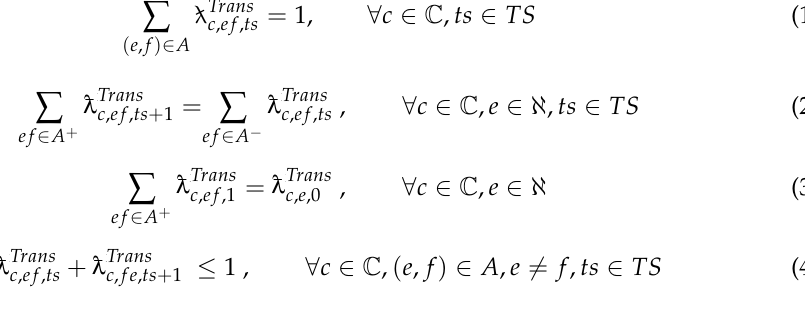
Figure 3. Time ‐ space network (TSN) concept. Equation (1) implies that MESS’s position can be located on any arc in time span